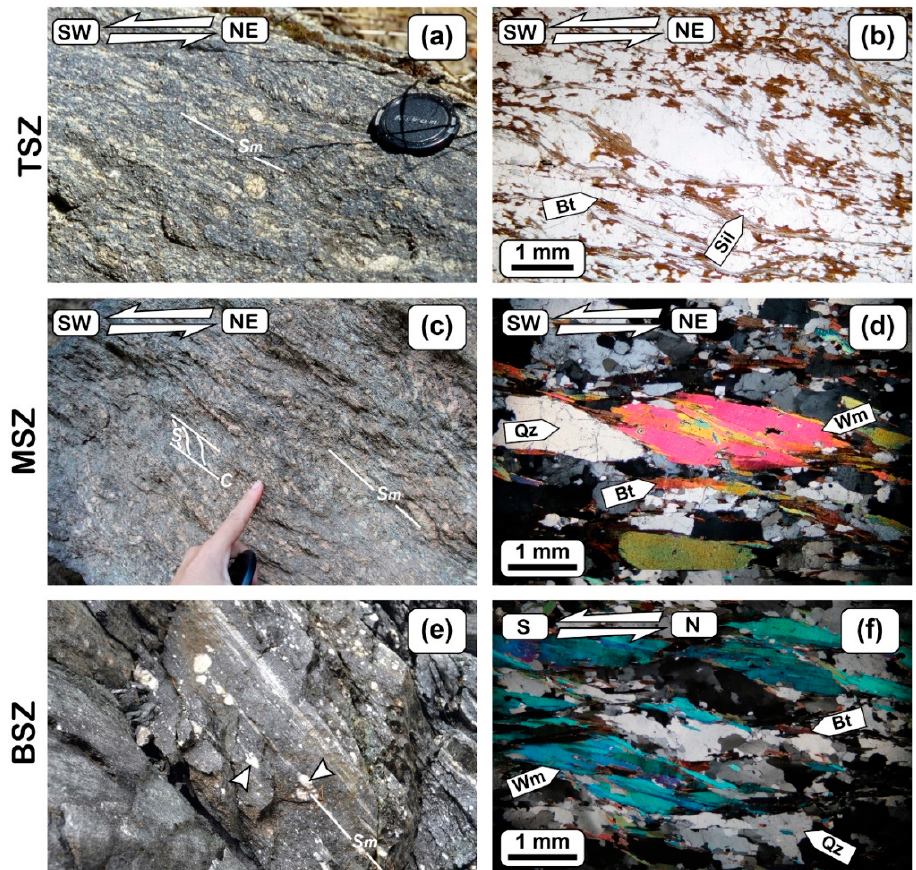
Figure 10. ( a ) Geological map of NW India [128]; ( b ) geological map of central Nepal. Same legend as in Figure 9 [125].